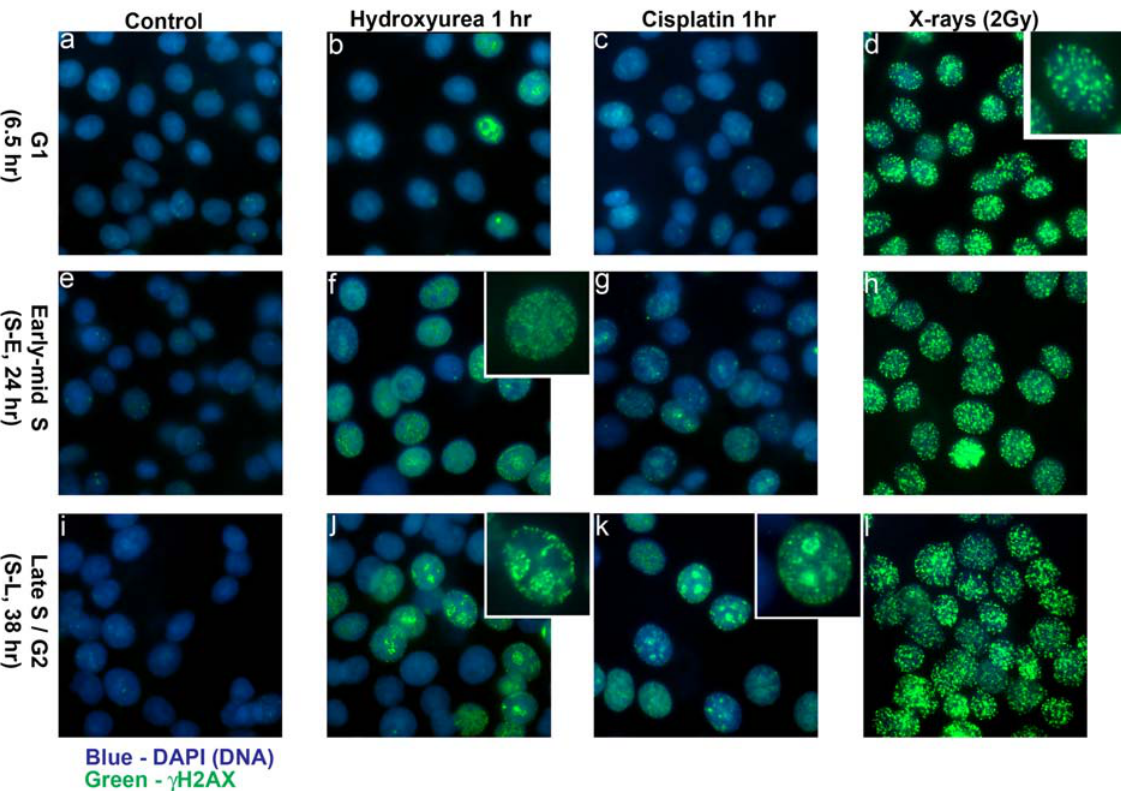
Figure 5. G 1 and S-phase H2AX phosphorylation. MCF7 cells were serum starved (0.05% FCS) for 24 hours before release into medium containing 20% FCS. Cells were fixed at different times such that fixed cell populations were predominantly in G 1 , early S (S-E) or late S-phase (S-L). (6.5 hr, 24 hr and 38 hr respectively). HU or cisplatin were added to the cells, to 2 mM or 50 m M respectively, at the indicated times prior to fixation. Irradiated cells were fixed 30 minutes after irradiation.